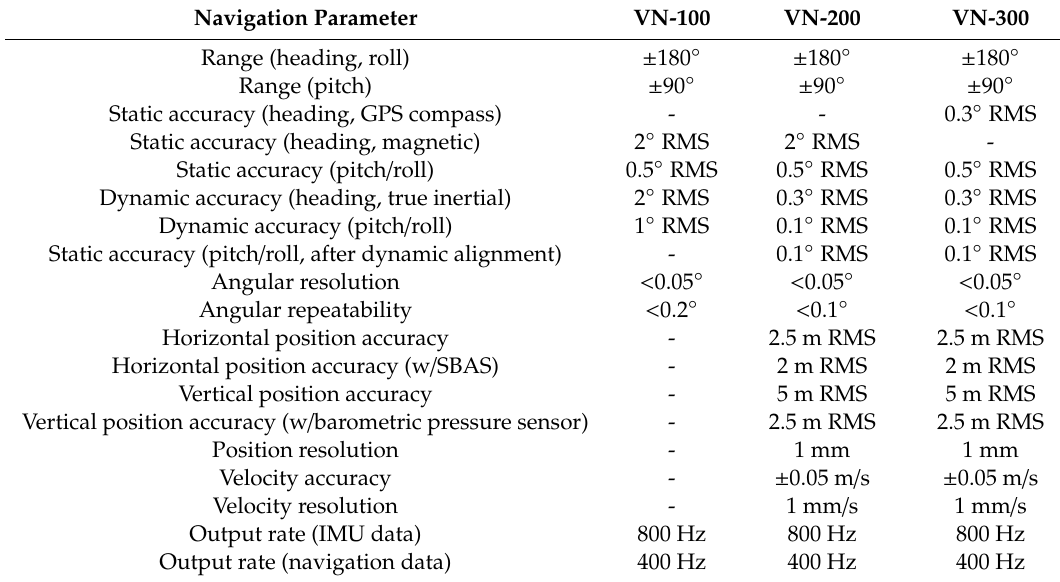
Table 4. Technical data of the VectorNav